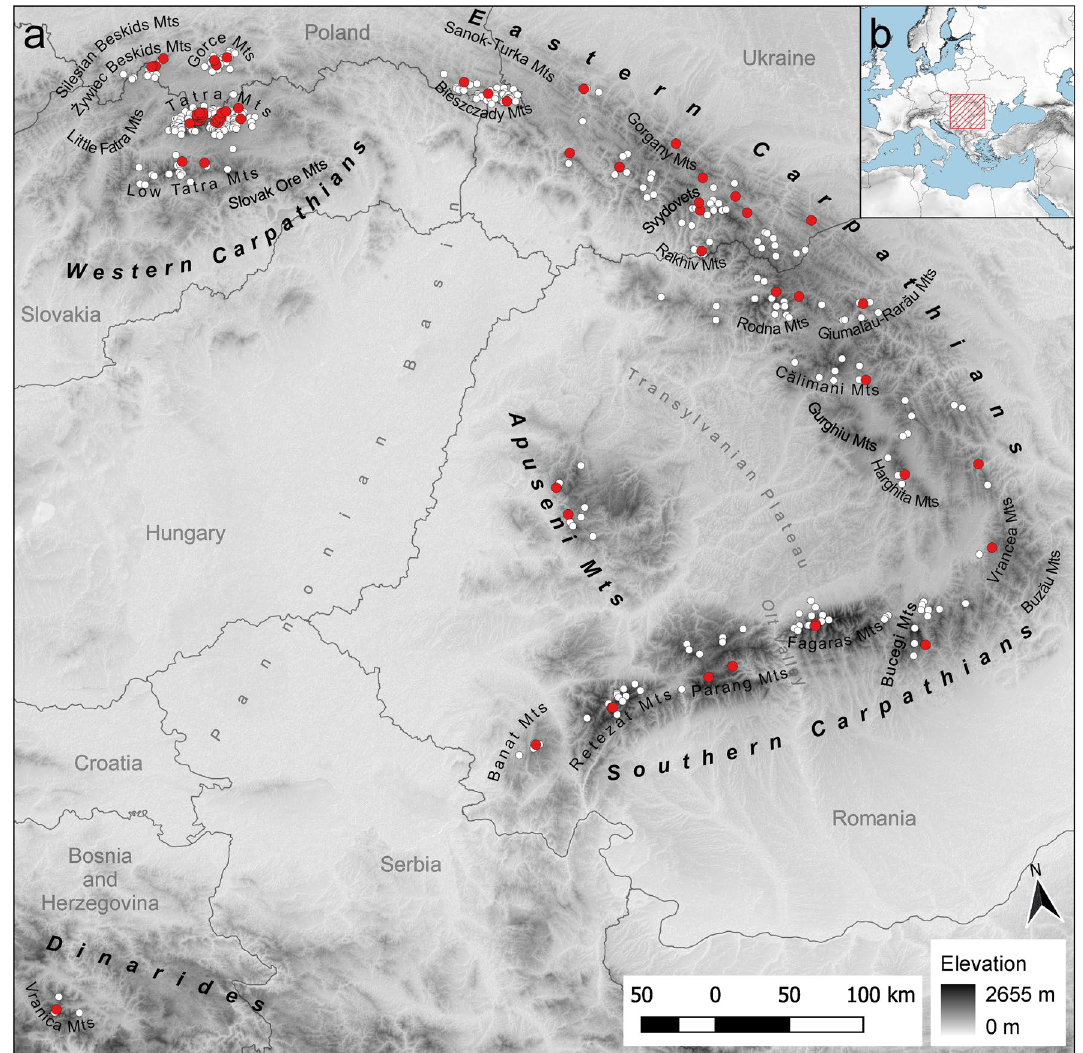
Figure 1. ( a ) The Carpathian region, the area of investigation of this study, with all geographic locations mentioned in the text. Red dots indicate locations sampled for the phylogeographic (cpDNA) study. White dots indicate locations used for ecological niche modeling. Country borders and names are shown for reference. ( b ) Placement of the study area. The underlying image represents the altitude derived from the ALOS DEM dataset 84 . The map is projected in ETRS89 (EPSG: 3035). The maps are drawn using R ver. 3.6.2 76 and QGIS